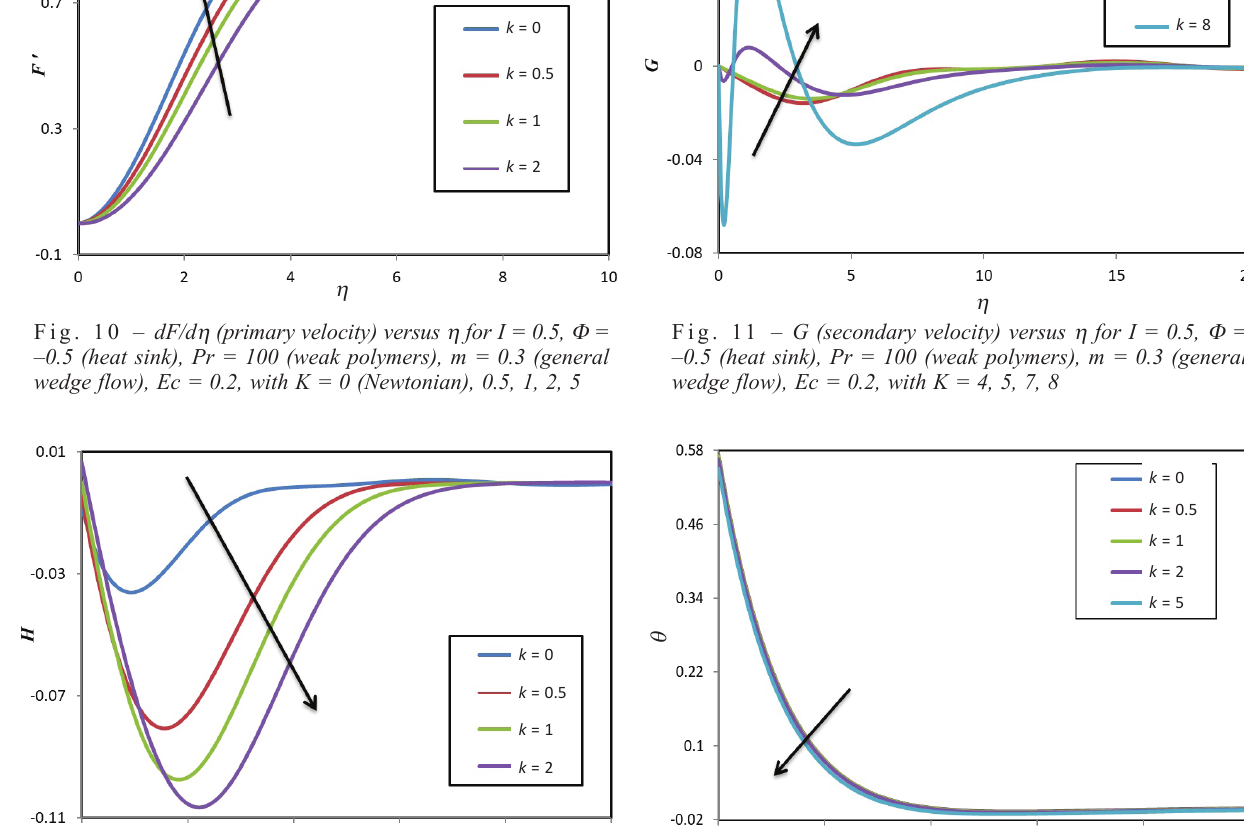
Fig. 12 – H (angular velocity) versus h for I = 0.5, F = –0.5 (heat sink), Pr = 100 (weak polymers), m = 0.3 (general wedge flow), Ec = 0.2, with K = 0 (Newtonian), 0.5, 1, 2, 5